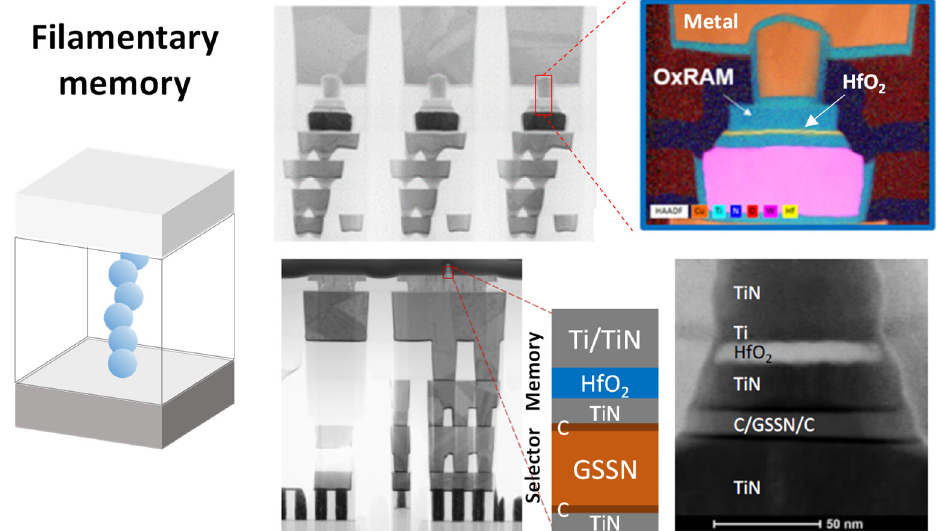
Figure 2. TEM cross sections of an HfO 2 based OxRAM integrated in the BEOL of a 28 nm FDSOI technology, from [44] (top) and an OxRAM/OTS device integrated in the BEOL of a 130 nm CMOS process, from [45] (bottom). The OTS (Ovonic Threshold Switch) backend selector is composed of a C/GeSeSbN/C stack.